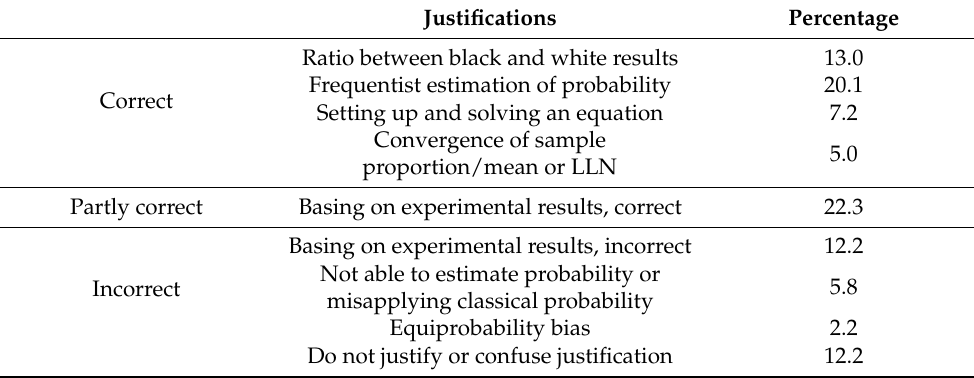
Table 2. Justifications given to Task